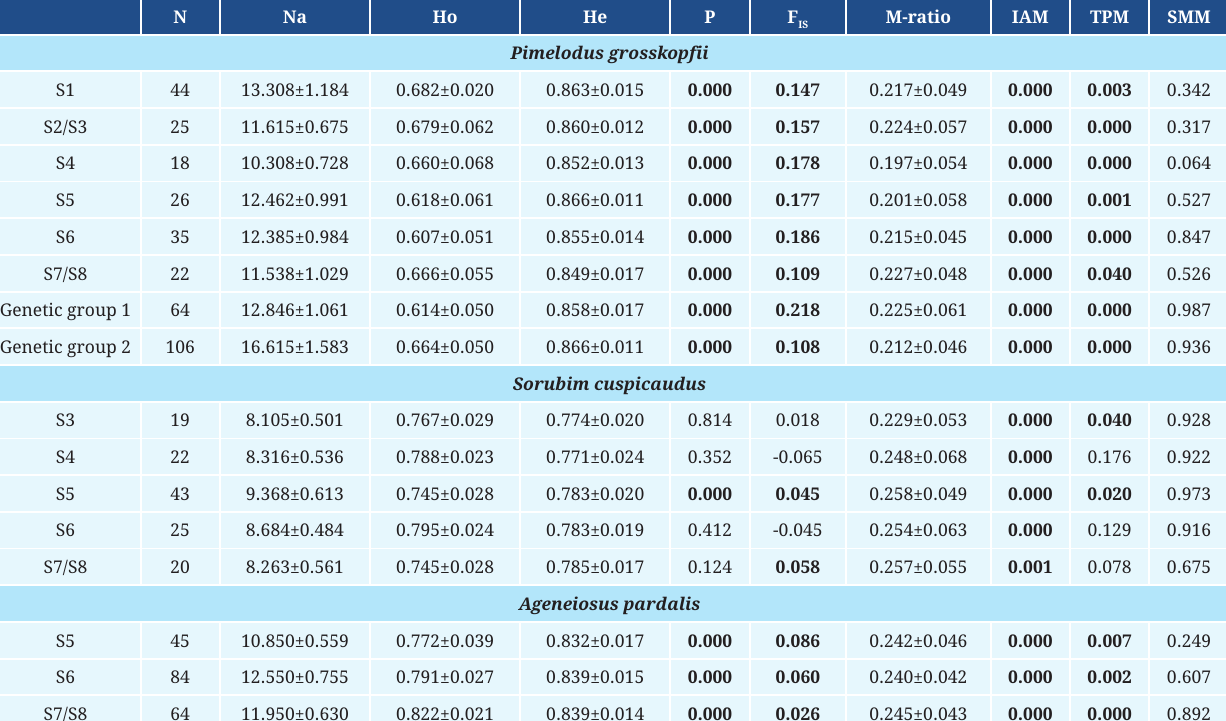
TABLE 2 | Genetic diversity, M-ratio estimator and bottleneck for populations and genetic groups of Pimelodus grosskopfii , Sorubim cuspicaudus , and Ageneiosus pardalis in the middle and lower sections of the Cauca River. N: Number of analyzed individuals, Na: Average number of alleles/locus, Ho: Observed heterozygosity, He: Expected heterozygosity, P: statistical significance of Hardy-Weinberg equilibrium; F : inbreeding coefficient, M-ratio: M estimator of Garza, Williamson (2001), IAM: infinite alleles model, TPM: two phase model, IS SMM: stepwise model. Values in bold denote statistical